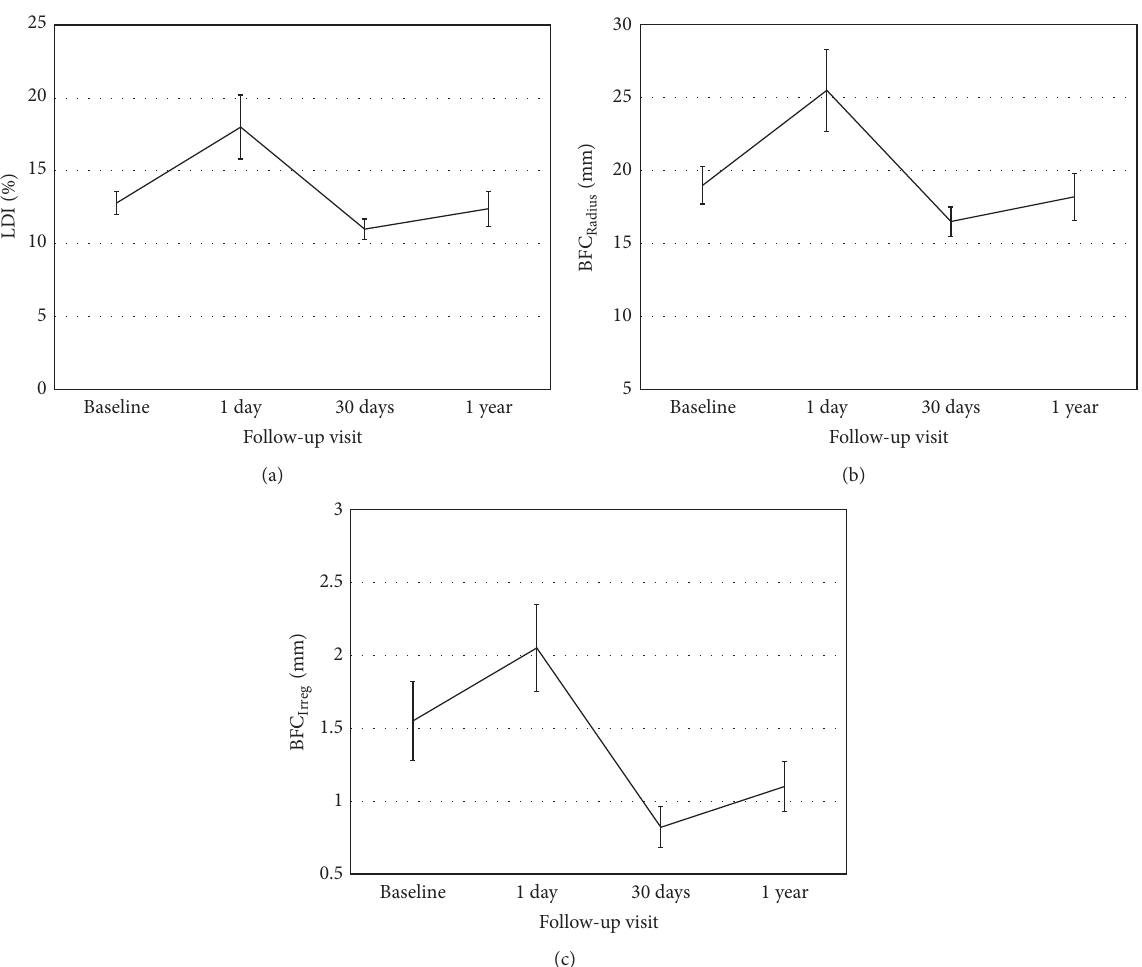
Figure 1: Monocular LDI (a), BFC